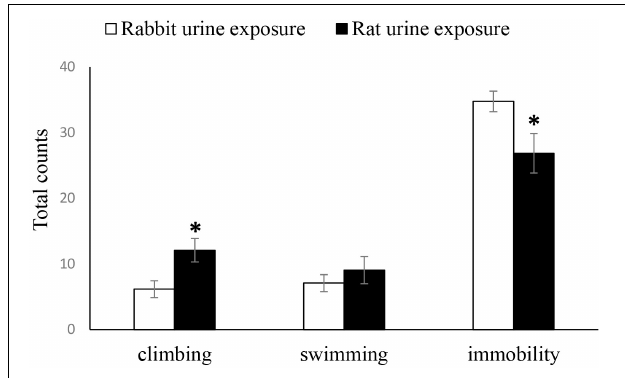
FIGURE 2 | Duration of immobility, swimming and climbing in rabbit urine exposure group, and rat urine exposure group. Data are expressed as the mean ± SEM ( ∗ p < 0.05 compared with the rabbit urine exposure